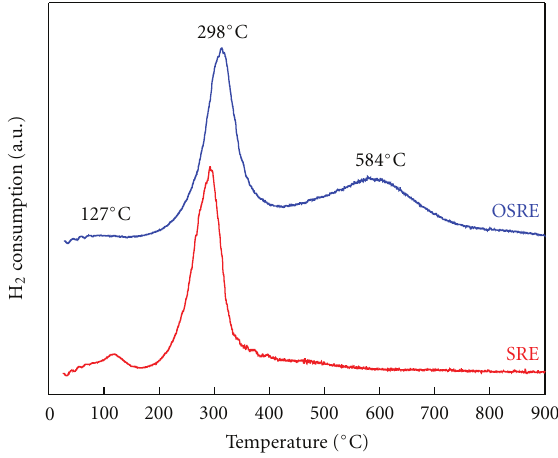
Figure 6: TPR profiles of used catalyst after SRE and OSRE